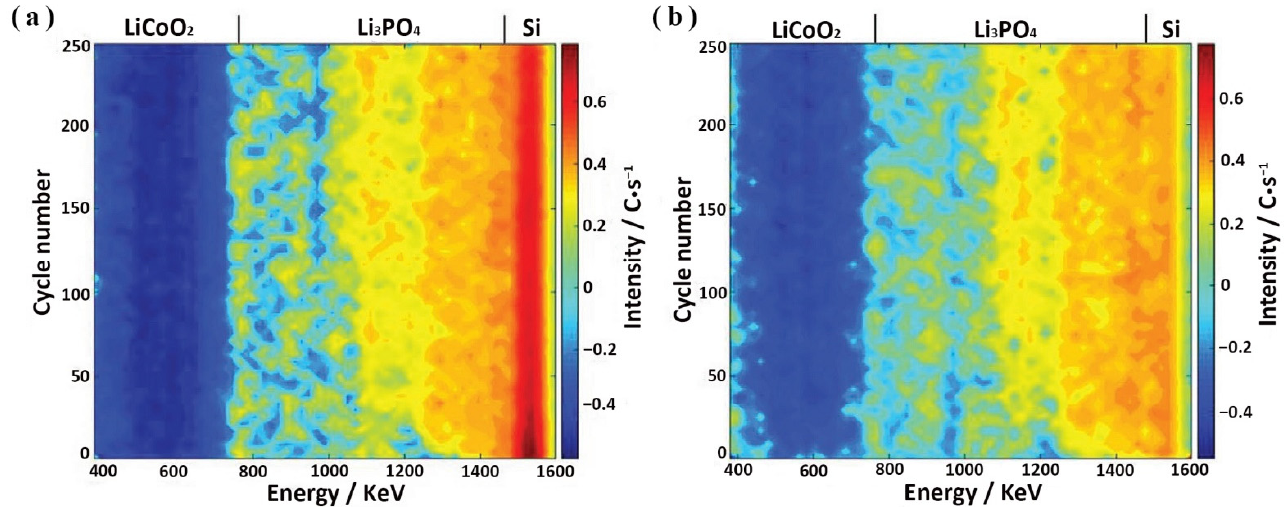
Figure 9. The evolution of the measured NDP spectra as an energy function of ( a ) fully charged and ( b ) discharged Si-Li 3 PO 4 -LiCoO 2 battery after 250 cycles (adapted with permission from Ref. [38]. 2018 Wiley-VCH).